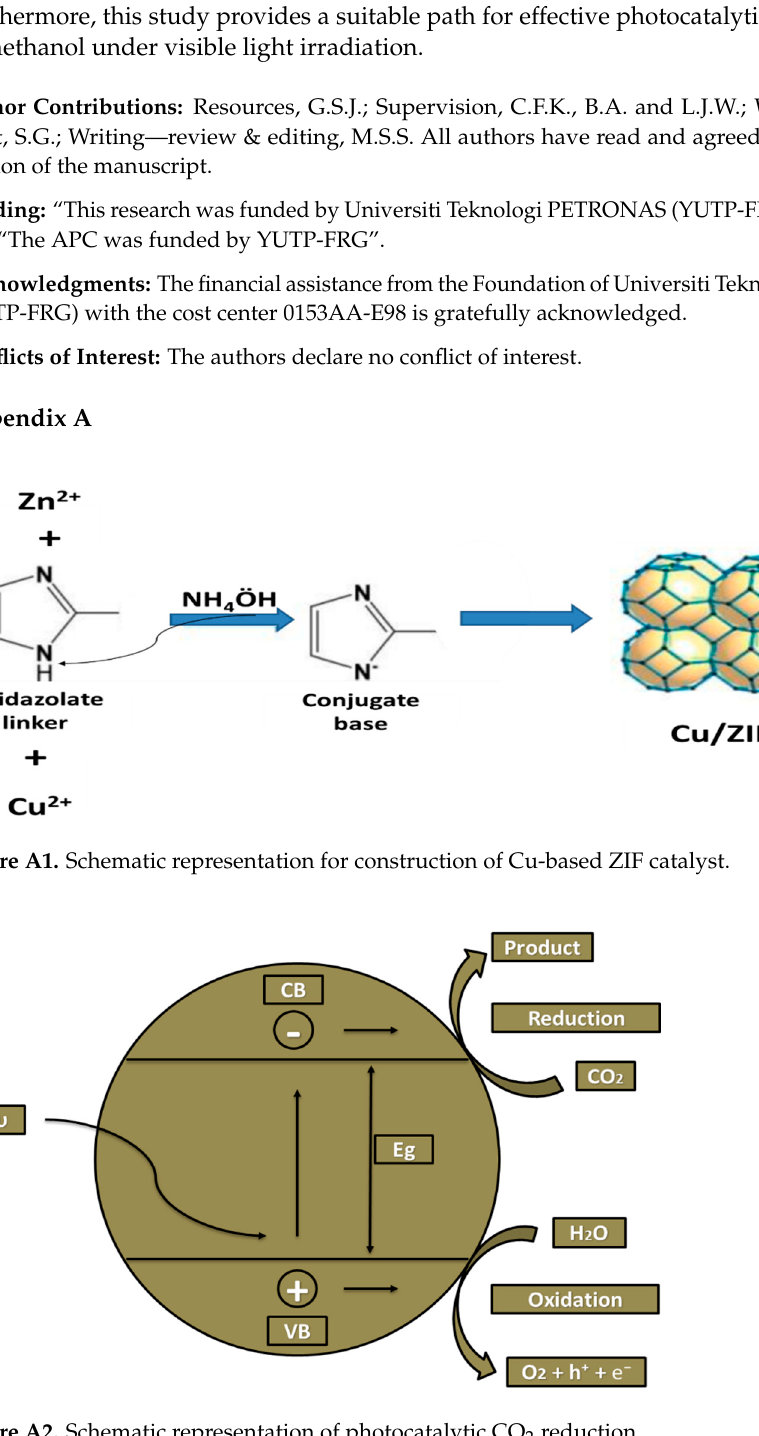
Figure A2. Schematic representation of photocatalytic CO 2 reduction.